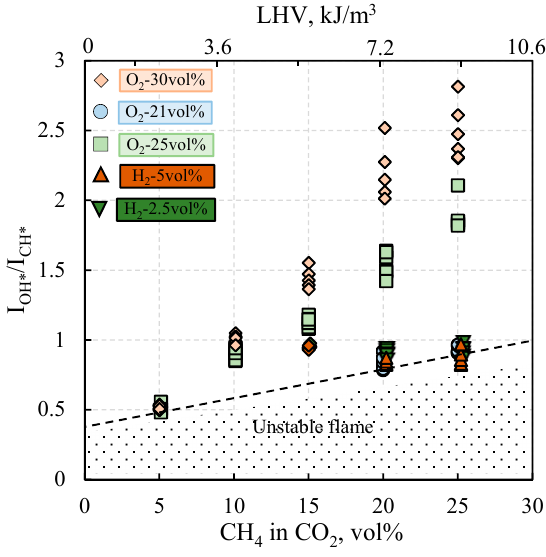
Figure 7. The tendency of the spectral intensity ratio of I OH* /I CH* with the increase of CH 4 content in CO 2 .